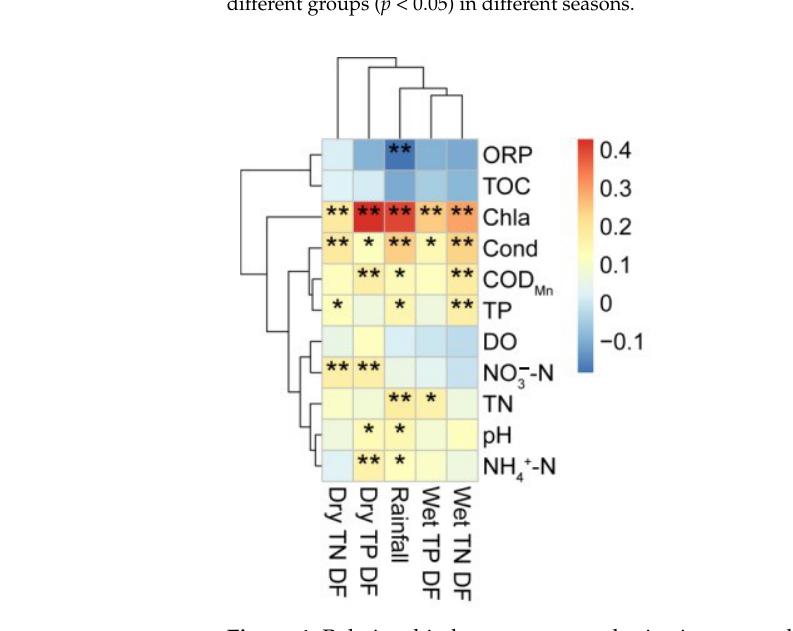
Figure 5. Redundancy analysis (RDA) of atmospheric nitrogen and phosphorus deposition and wa- ter quality factors in Henan Canal.